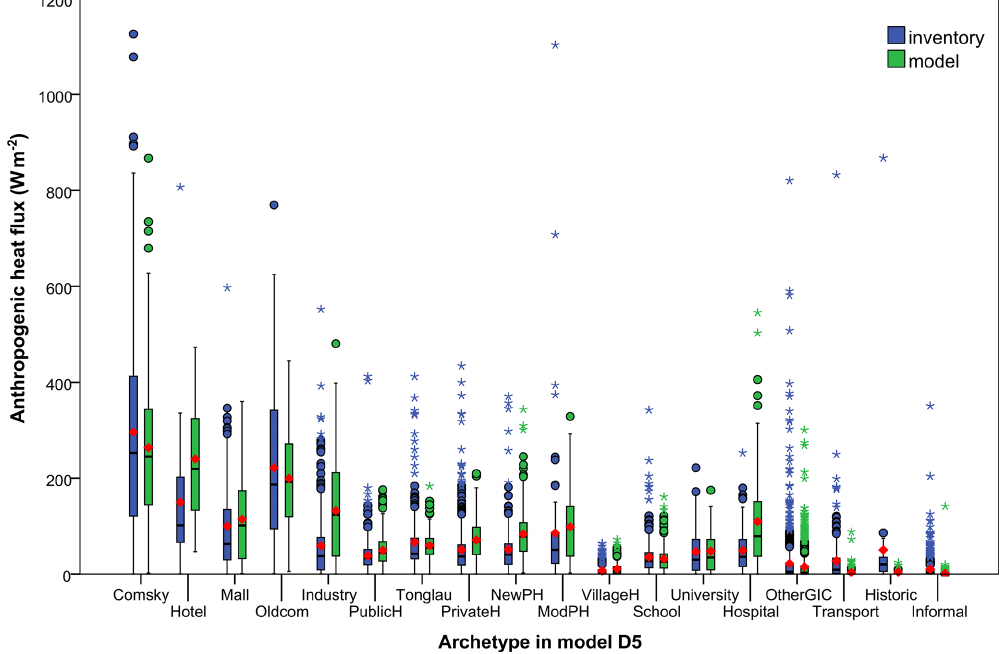
Figure 13. Statistical distribution of the anthropogenic heat flux due to building energy consumption in D5 as a function of the dominant building archetype at grid-point scale. In the boxplots, the black line denotes the median and the red diamond the mean. Comsky denotes commercial skyscraper; Oldcom denotes old commercial building; PublicH (PrivateH) denotes public (private) housing; NewPH (ModPH) denotes newer (modern) private housing; VillageH denotes village house; other GIC denotes other government, institutional, and community buildings; and Historic denotes historical building. Table 3. Comparison of evaluation measures for air temperature with previous studies. (cid:49) is the model resolution. SLUCM denotes the single-layer urban canopy